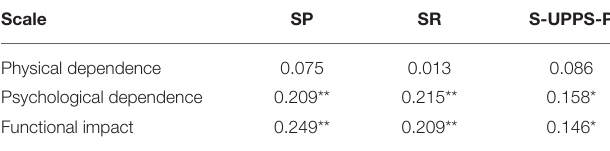
TABLE 4 | Correlation coefficients between the SDDS and other related